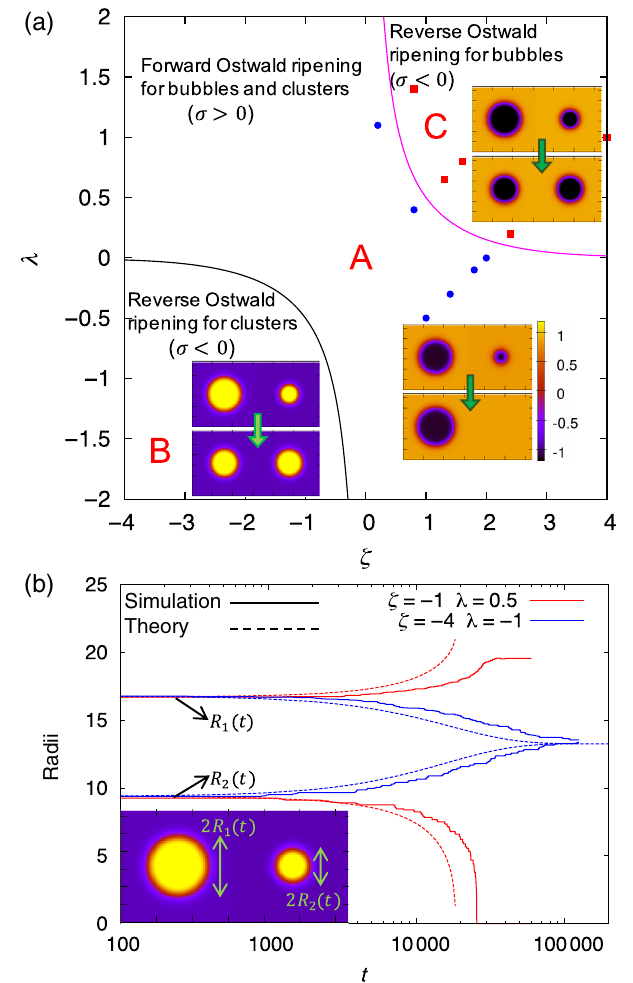
FIG. 4. (a) Mean-field phase diagram of AMB+ with K ¼ 1 , K 1 ¼ 0 , and any value of A > 0 , in d ¼ 2 , 3. Ostwald ripening is reversed where σ < 0 . In region A, σ > 0 , and we have normal or forward Ostwald ripening for both bubbles and droplets. In region B (resp. C), Ostwald ripening is reversed for dense droplets dispersed in a dilute environment (resp. dilute bubbles in a dense environment). Points are results from simulations of two droplets (red squares for reverse and blue circles for forward Ostwald ripening). (b) Evolution of two droplets with initial radii R 1 > R 2 for ð ζ ; λ Þ ¼ ð − 1 ; 0 . 5 Þ (red), corresponding to region A, and ð − 4 ; − 1 Þ (blue), corresponding to region B. Solid lines are direct numerical simulations of Eqs. (5) and (6) with D ¼ 0 , and dashed lines are predictions from our theory (see Appendix E). We observe forward Ostwald ripening in the first case and reverse Ostwald ripening for the second, as